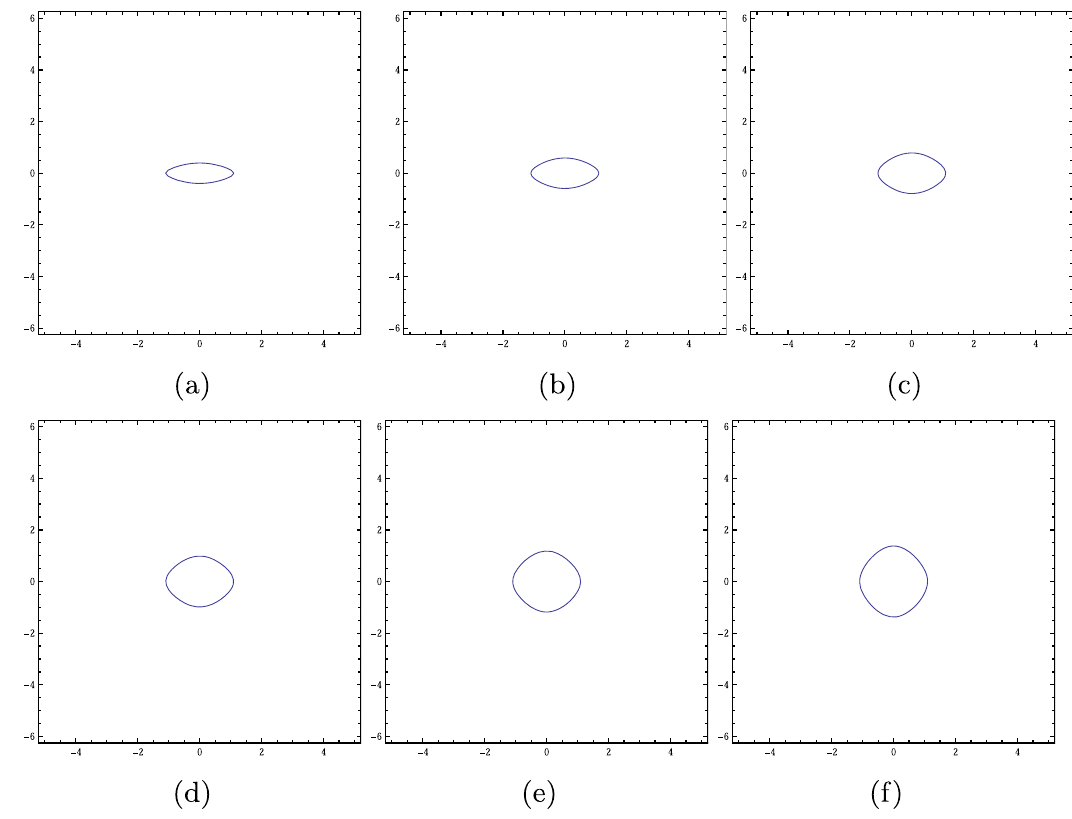
Figure 3: The shape of metric ball ( ) δ x x , t 1 2 when we fi x = t 0.3 , = a 1 and b changes from 1 to 3.5 in the interval of 0.5.